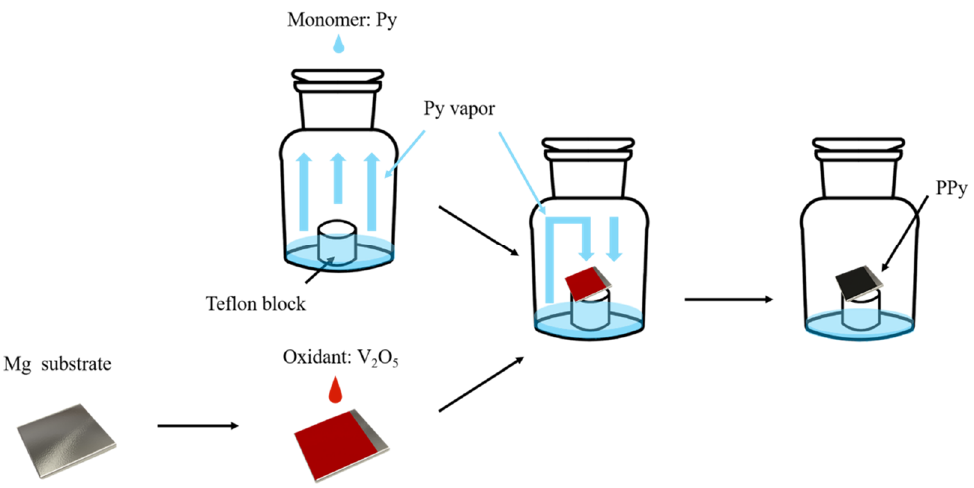
Figure 1. Schematic diagram for the synthesis of the polypyrrole (PPy)/vanadium pentoxide (V 2 O 5 ) composite film on the Mg surface by the mild vapor phase polymerization (VPP) method.